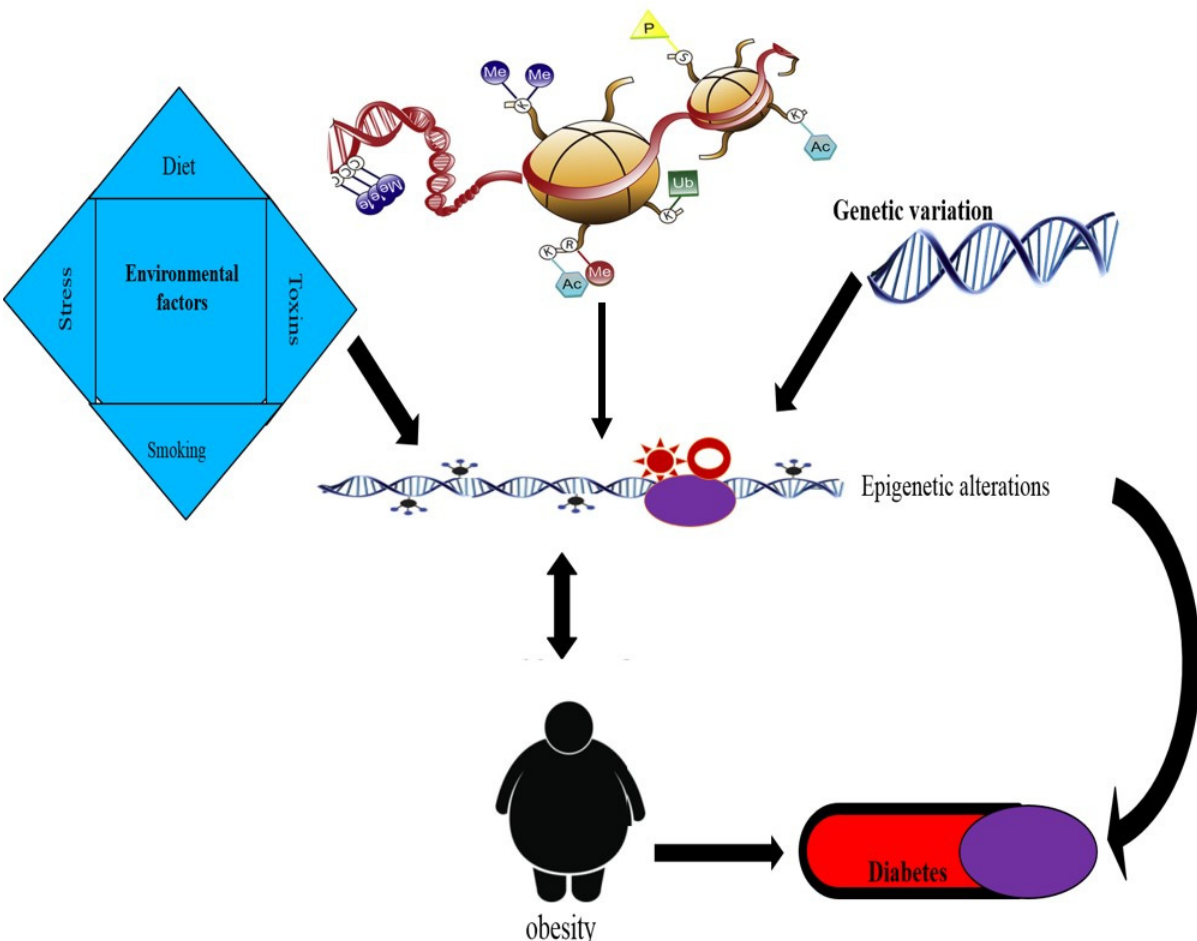
Figure 2. Hypothesis of inter-relationships between environmental factors, genetic variation, epige- netic changes, obesity, and diabetes .